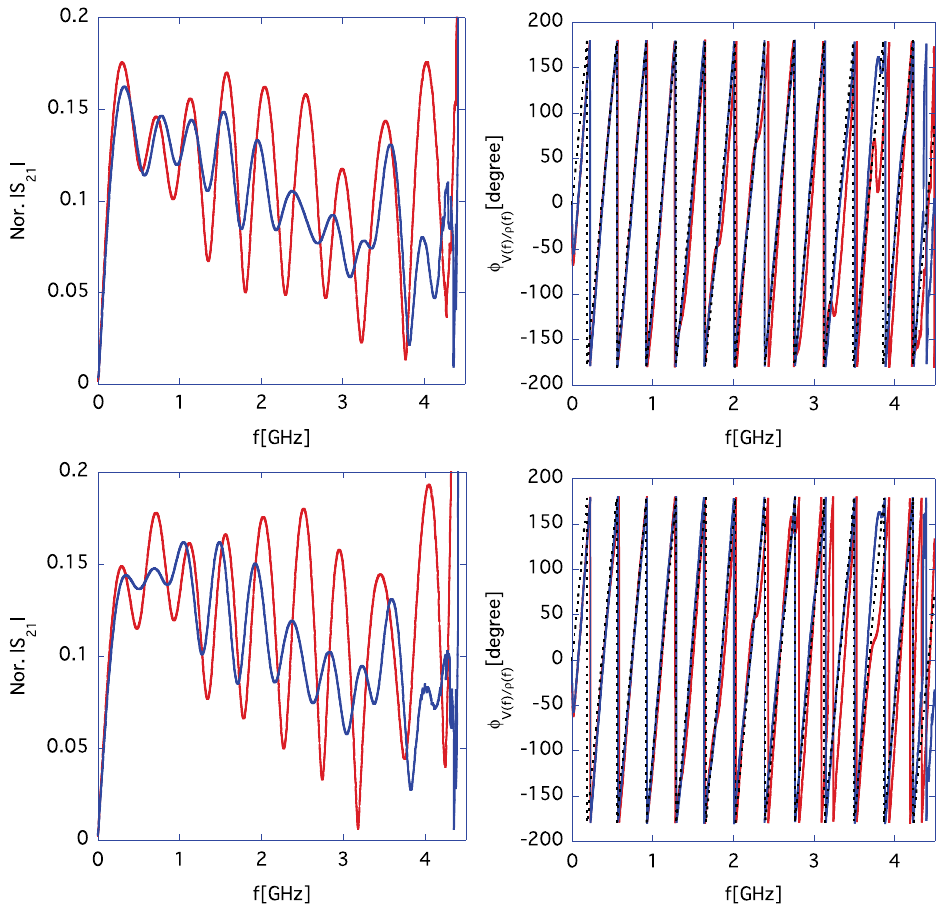
FIG. 23. Measured S 21 after the TDG treatment for the triangle (top) and the concave pentagon (bottom) electrodes with (blue) and without (red) apron. The dotted line shows the line ϕ ¼ 2 π ft 2 · 180 = π for reference, where t 2 is the time at the peak point of inverse Fourier transform of S 21